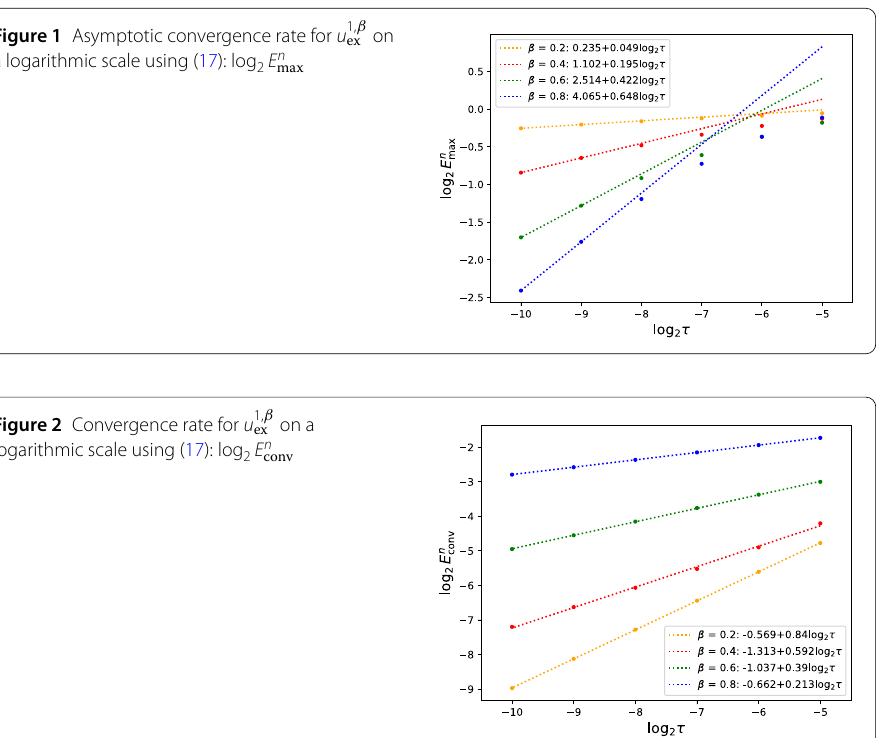
Figure 2 Convergence rate for u 1, β ex on a logarithmic scale using (17): log 2 E n